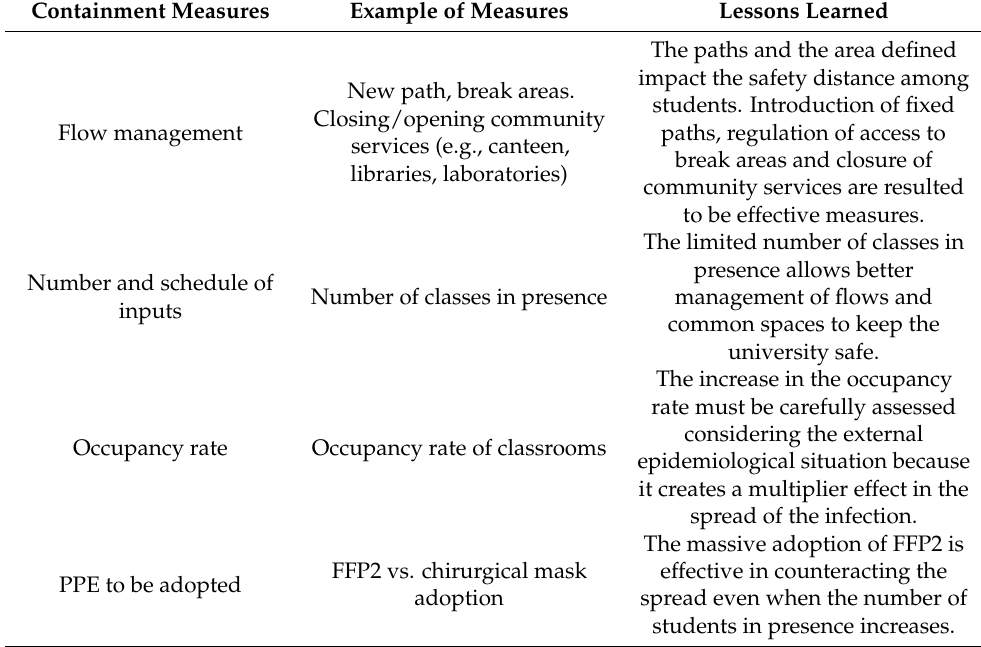
Table 11. Containment measure assessed throughout simulation and lesson